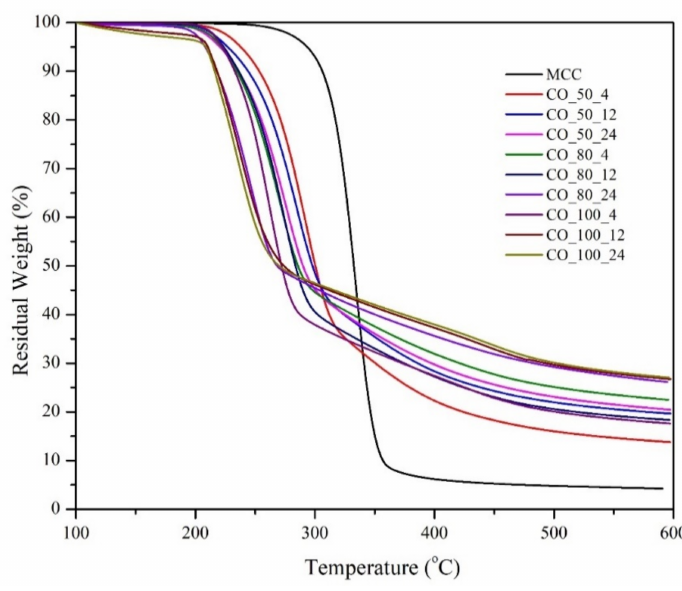
Figure 5. TGA thermograms of unmodified MCC and modified